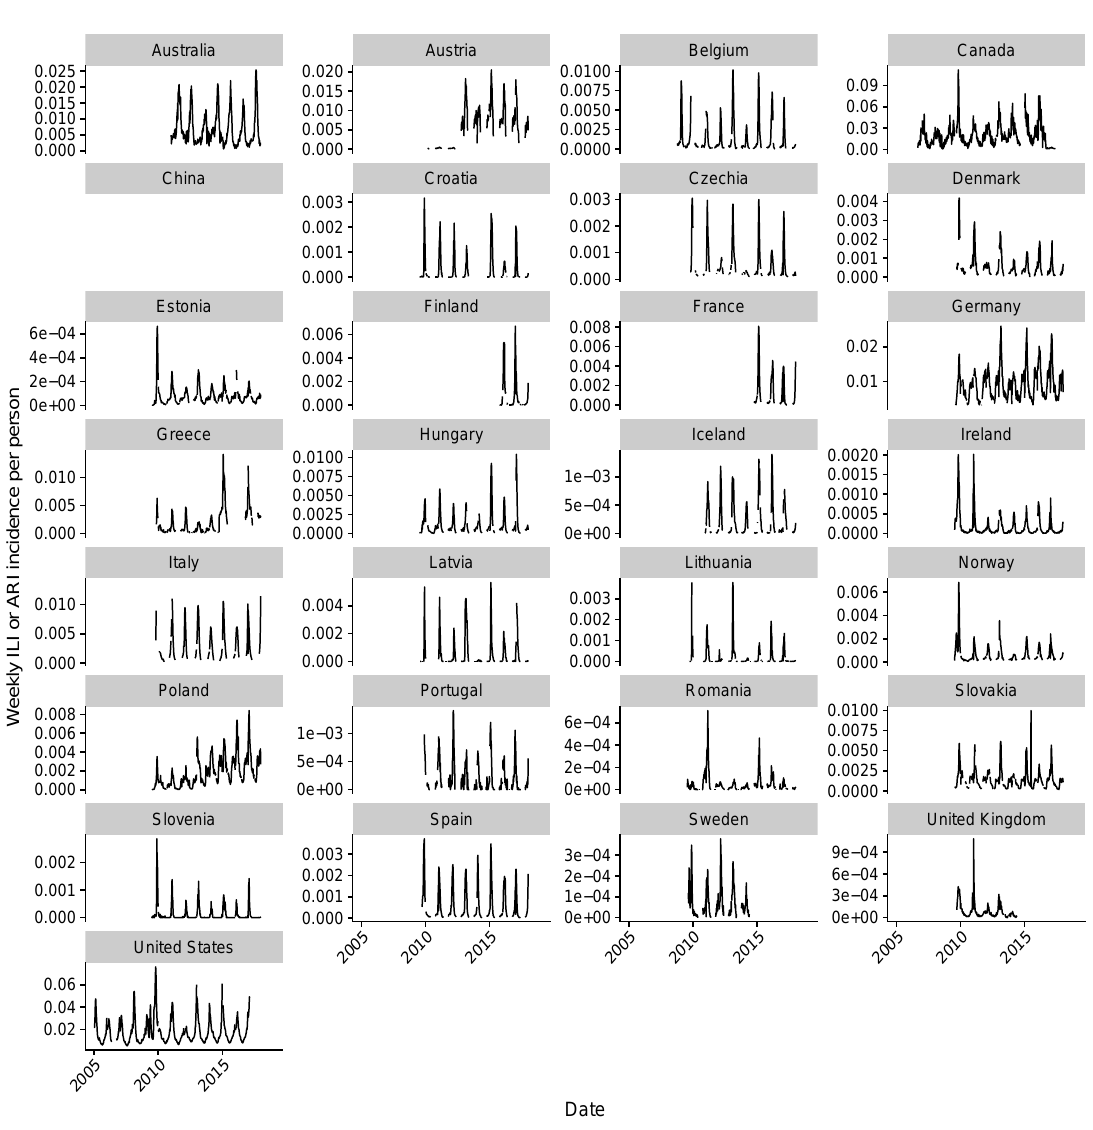
Figure A7. Country-level seasonal influenza-like illness (ILI) or acute respiratory illness (ARI) incidence are shown, as reported in the WHO FluID database [53]. ILI incidence as reported is shown for all countries except for France and Germany. Before the 2014–2015 season, ILI incidence in France is estimated from ARI incidence. ARI incidence is shown for Germany. Incidences are reported at weekly resolution. A fixed y -axis scale is shown in Figure